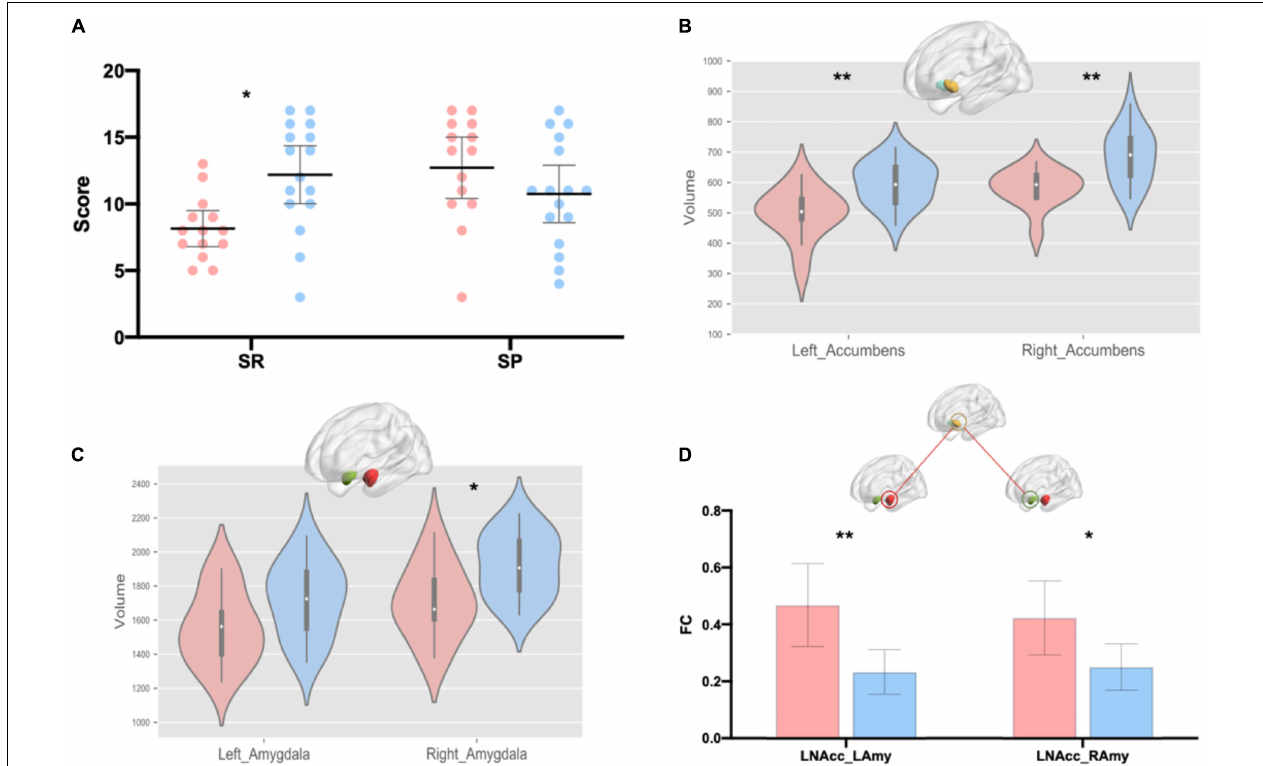
FIGURE 1 | Group differences in the SPSRQ, volume of nucleus accumbens and amygdala, and resting-state functional connectivity between the bilateral amygdala and left nucleus accumbens. (A) Group differences in the sensitivity to reward and punishment. Data are means with 95% CI. (B) Group differences in bilateral nucleus accumbens. (C) Group differences in the bilateral amygdala. (D) Group differences in the resting-state functional connectivity between the bilateral amygdala and left nucleus accumbens. Pink represents the high holistic thinker group and blue represents the low holistic thinker group. SR, sensitivity to reward,